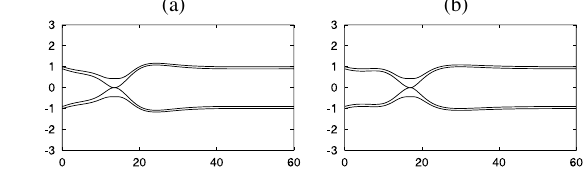
Fig. 5 Breakup profiles of the jet for di ff erent ¯ u 1 when η = 0 . 1, ρ = 0 . 001, σ = 1, ¯ b = 0 . 1 and ¯ u = 1, where Wb = 125 and ω = 0 . 04; (a) ¯ u 2 and (b)¯ u 1 = 1 . 4 at t = 20 . 0.